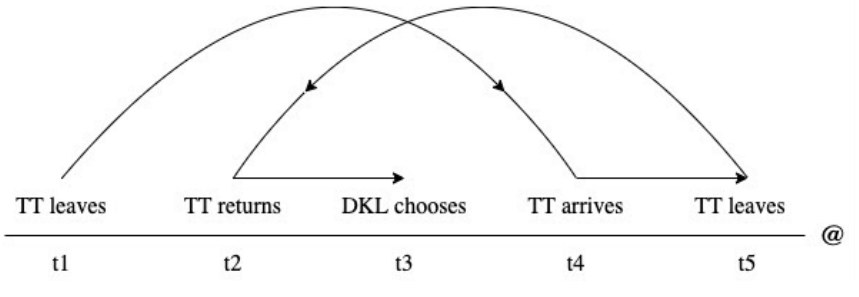
Figure 1. The time-traveling Newcomb game